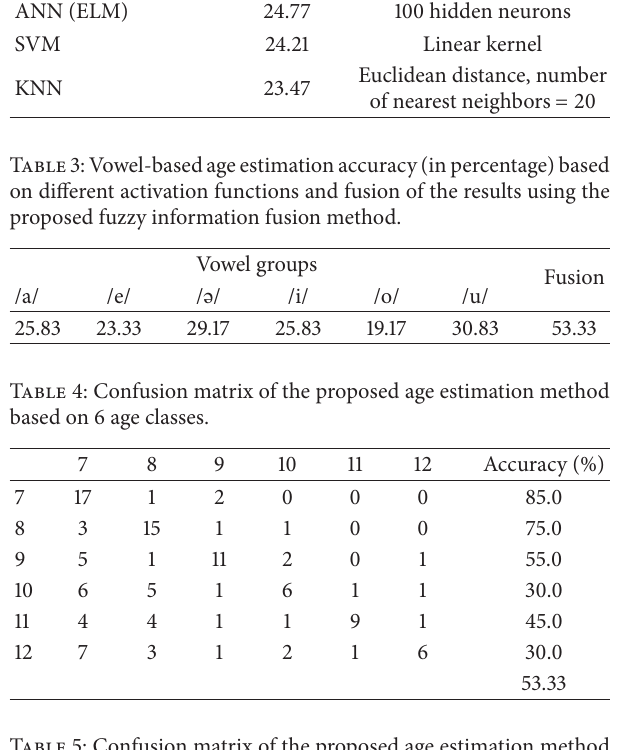
Table 5: Confusion matrix of the proposed age estimation method based on 3 age